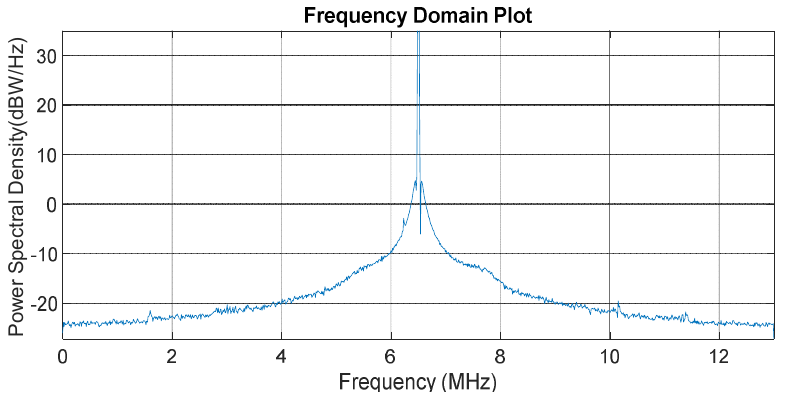
Figure 20. Input sampled data with the CW jammer at J/No = 80 dB-Hz and freqj = 6.5033 MHz .